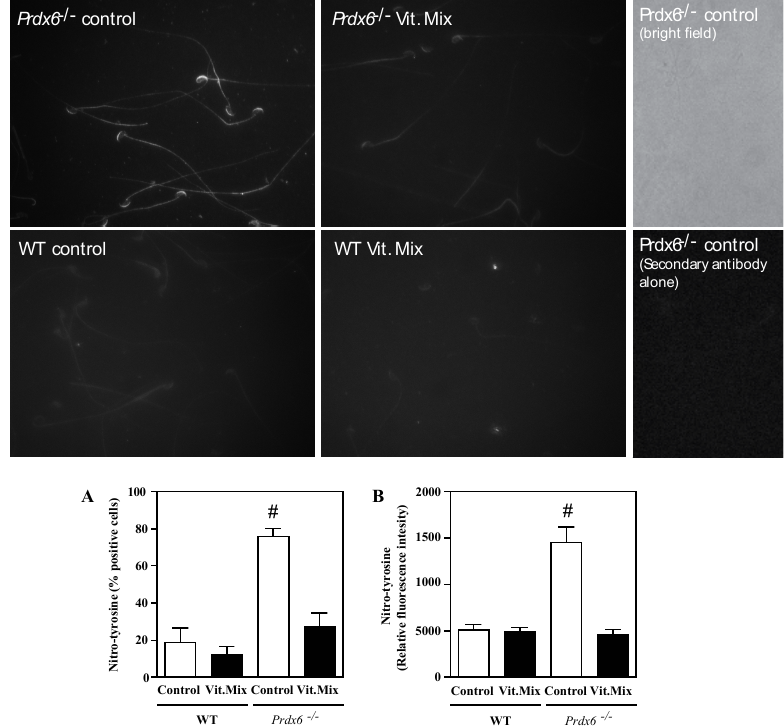
Figure 6. Tyrosine nitration in spermatozoa from WT or Prdx6 ‐ / ‐ males fed with control (open bars) and Vit. Mix (black bars) diets, respectively. Unspecific binding was ruled out by incubating Prdx6 ‐ / ‐ spermatozoa with secondary antibody alone (right panels). Percentages ( A ) and relative fluorescence intensity ( B ) were determined by immunocytochemistry, and analysis of the fluorescence was performed using the ImageJ software. # means higher than all the other groups. P ≤ 0.001, two ‐ way ANOVA and Tukey tests. Despite the primary effects of the genotype already observed and of the treatment, we observed interactions between the genotype and the type of diet in all the parameters studied except for the sperm motility and number of pups, indicating that infertile males with significant damage due to oxidative stress and tyrosine nitration in their sperm benefit from the antioxidant treatment (Table 2). In the case of the number of pups, the p value of 0.06 indicates the existence of a trend of interaction. Table 2. Complete summary ( p ‐ values) of statistical analysis by two ‐ way ANOVA.